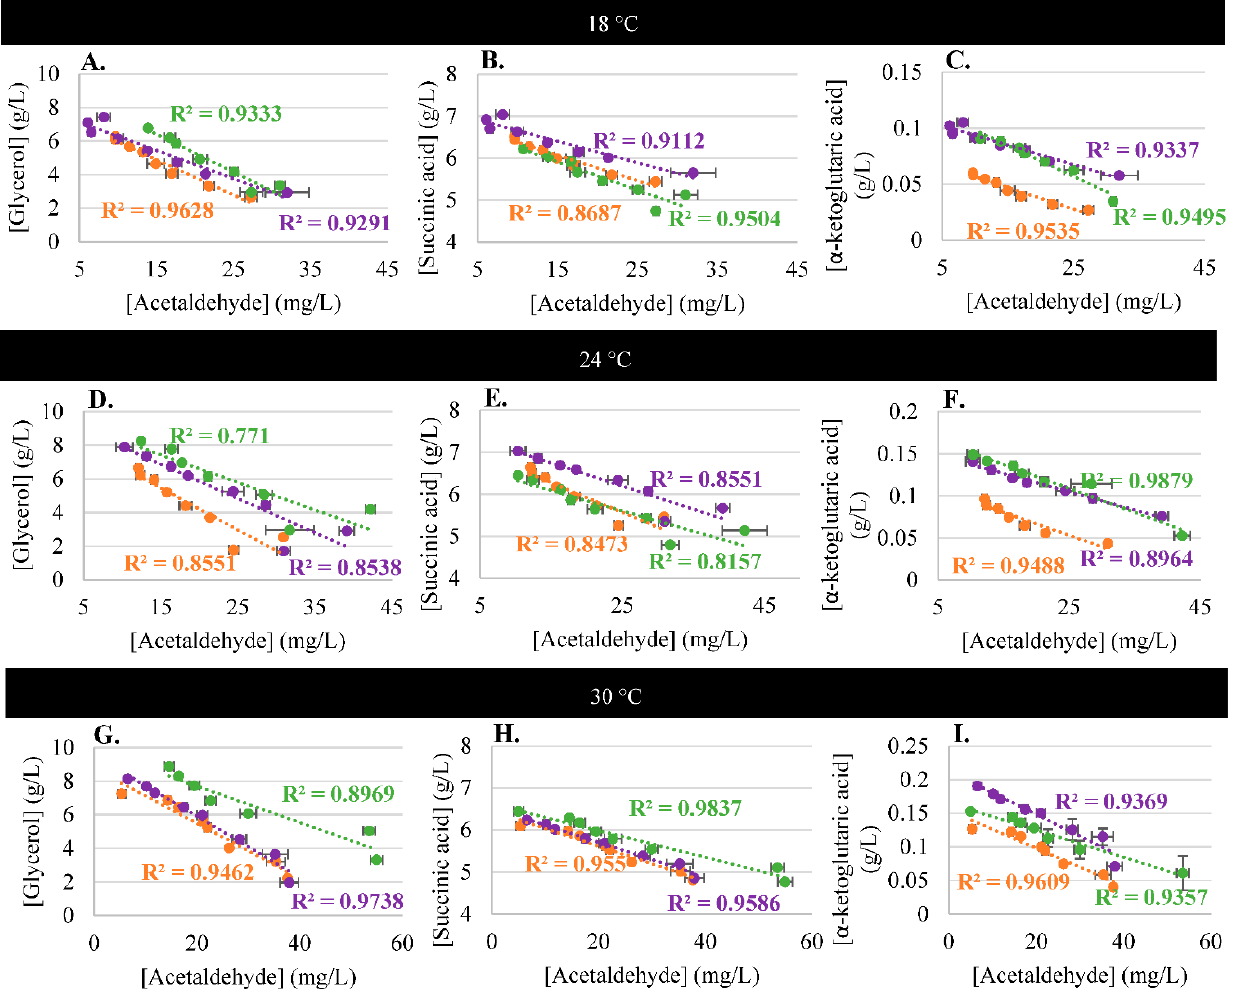
Figure 4. Correlation between the production of glycerol ( A , D , G ) and the organic acids succinate ( B , E , H ) and α -ketoglutarate ( C , F , I ), with acetaldehyde synthesis for the three isothermal temperatures (18, 24 and 30 °C) for strains FC9 ® (orange), SM102 ® (purple) and 7013 ® (green).